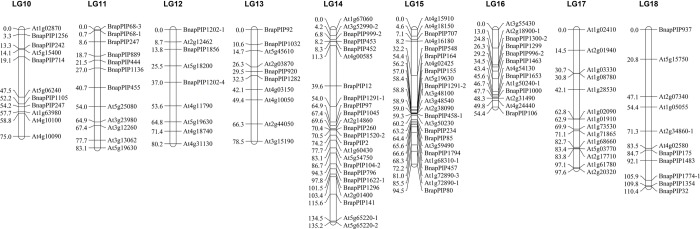
The 9 linkage groups from LG10 to LG18 in Brassica juncea.For each linkage group, the ILP markers were shown on the right side and the marker position in centiMorgan on the left side.